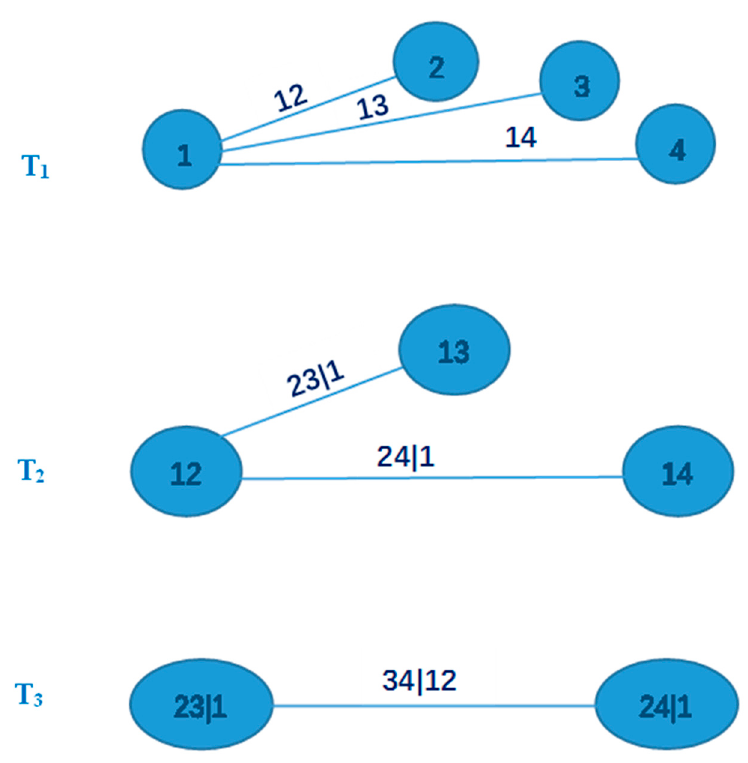
Figure 2. Structure of a 4-dimensional C-vine.